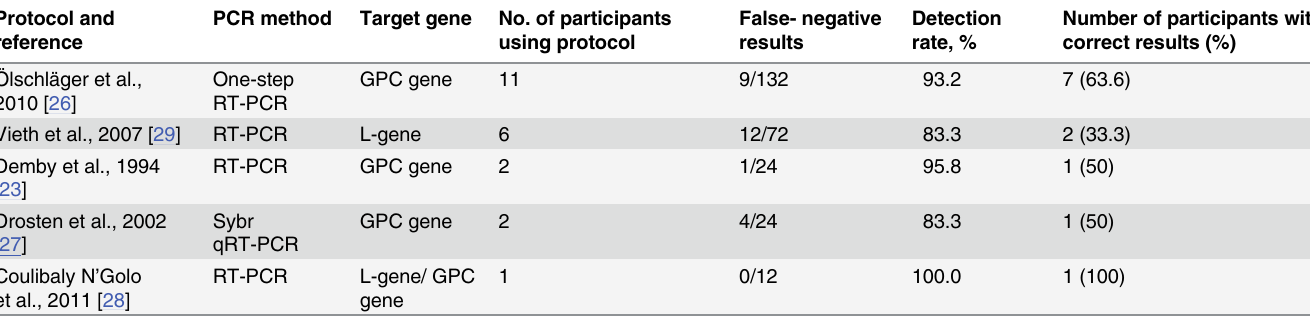
Table 5. Summary of the published protocols used by the participating